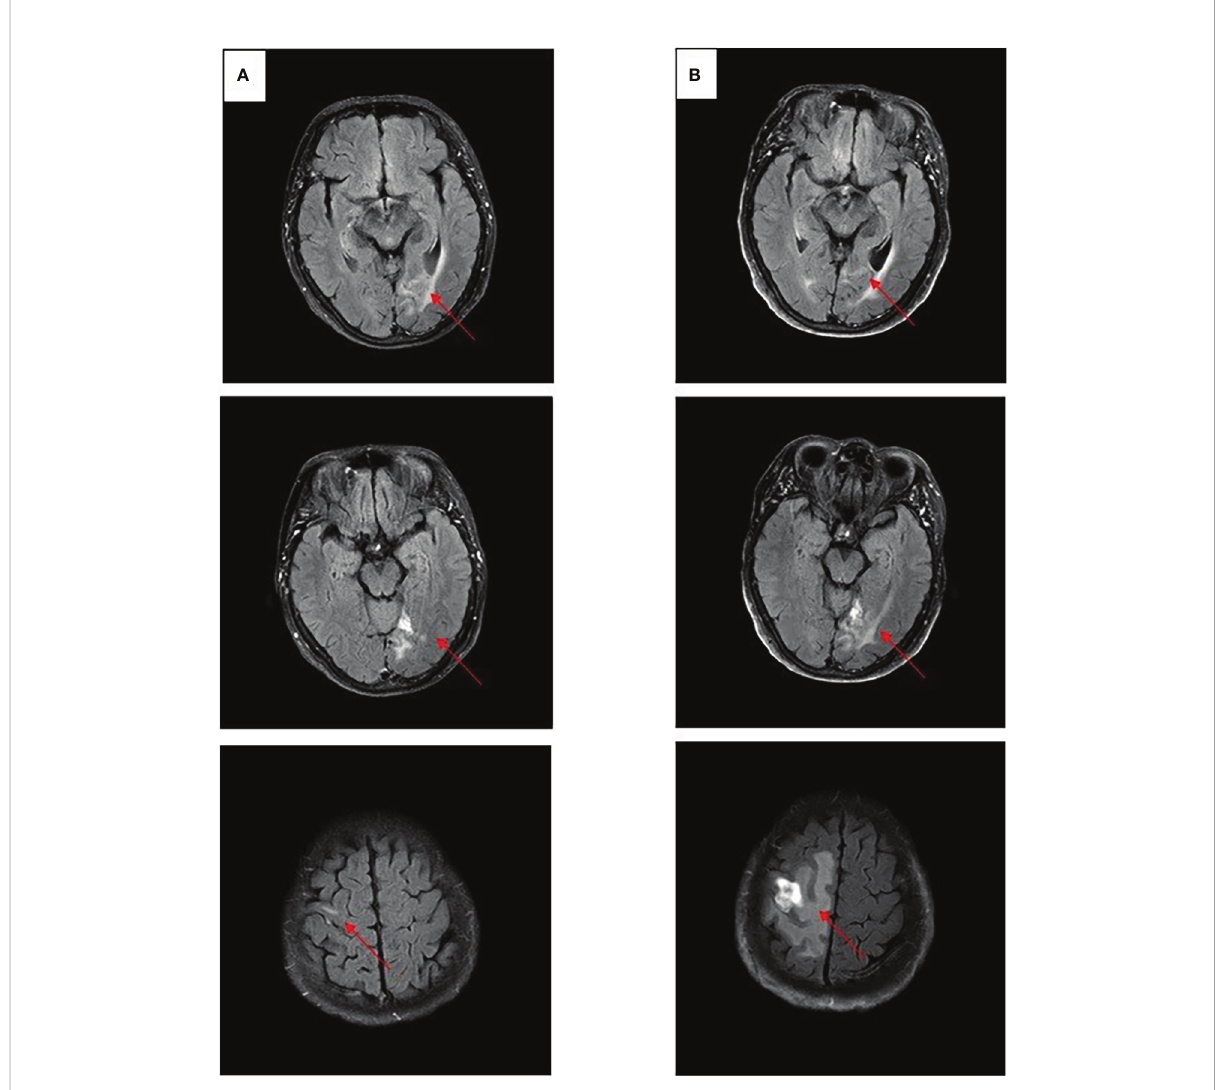
FIGURE 4 Craniocerebral MRI about clinical response to dacomitinib therapy at different times. (A) Brain metastases still PR after 12 months. (B) Brain metastases PD after 17 months.